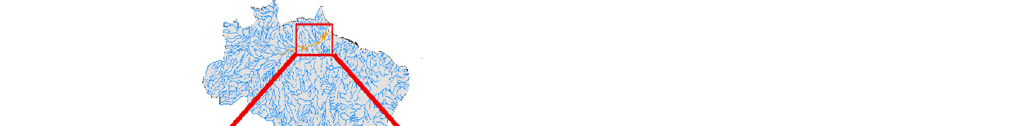
Figure 1. ( A ) Sampling points along the Lower Amazon region during 2014–2017 field campaigns; ( B ) 1928–2020 monthly mean precipitation; ( C ) seasonal discharge of the Amazon River during 2012–2017 with field campaigns indicated (T1– T6). Discharge and precipitation data were acquired at the Óbidos station (National Water Agency of Brazil, ANA, www.ana.gov.br, (accessed on 9 March 2021)); ( D ) Amazon River water color, 16 July 2015; ( E ) Xingu River water color, 12 July 2015; ( F ) Tapajos River water color, 7 July 2015. Samples were collected at stations along the Amazon mainstem, in a series of expe- ditions by the research vessel M/V Mirage, at Óbidos, below Santarem, Almeirim, and two primary channels near the geographical river mouth by Macapá. At Óbidos, the width of the Amazon River is 2.3 km, and, at Macapá, each channel has a width of 11 km. The width of the mainstream at the Lower Amazon is stable and has little variation along the sea- sonal discharge [36]. The location of Óbidos is crucial for monitoring the dynamics of the Amazon basin. It is the furthest downstream monitoring gauge of the Brazilian National Water Agency (ANA) where the mainstem has already received the contribution from large rivers, such as the Solimões, Negro, and Madeira, and from other smaller tributaries. Downstream of Óbidos, the Amazon River receives the inputs from two large tributaries: the Tapajós and Xingu rivers. The downstream boundary of our study was the north and south channels near Macapá, which are the last two well-constrained channels near the Amazon River